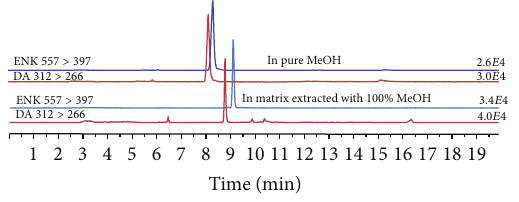
Figure 1: Comparison of extract ion chromatogram of DA and ENK standard solution diluted in pure methanol and in matrix extracted with